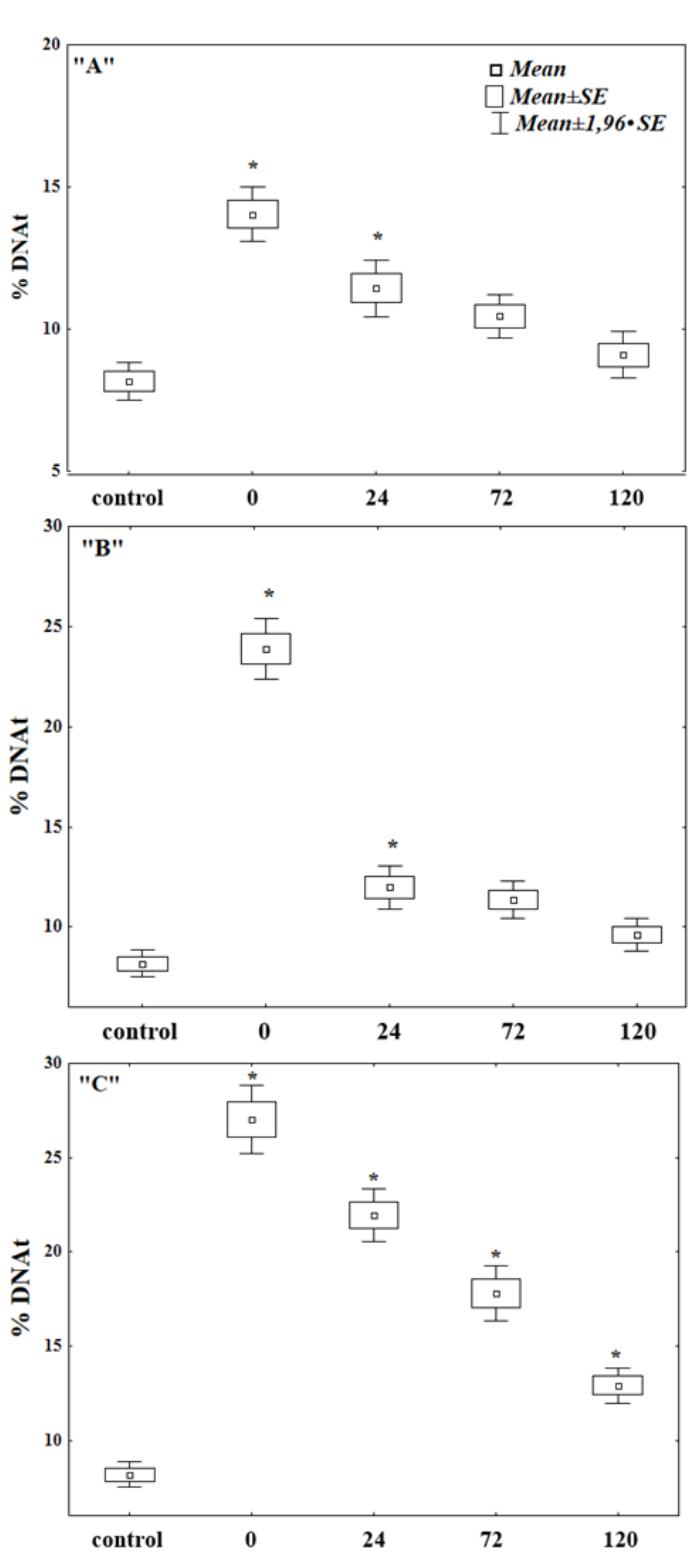
Figure 3. DNA damage in the gills of M. trossulus . 0, 24, 72, 120 h—depuration. * Difference from the control is significant ( p < 0.05). Mean ± 1,96 • SE confidence interval for the population mean with a probability of 95%.